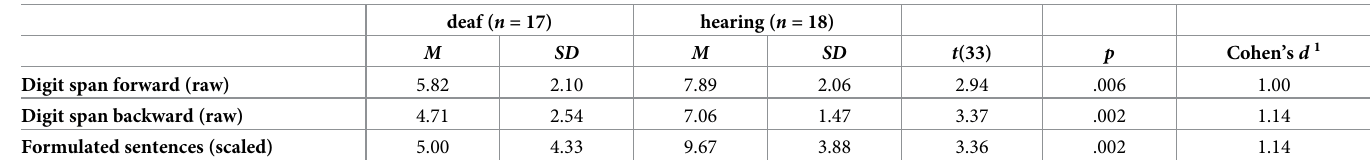
Table 4. Standardised tasks